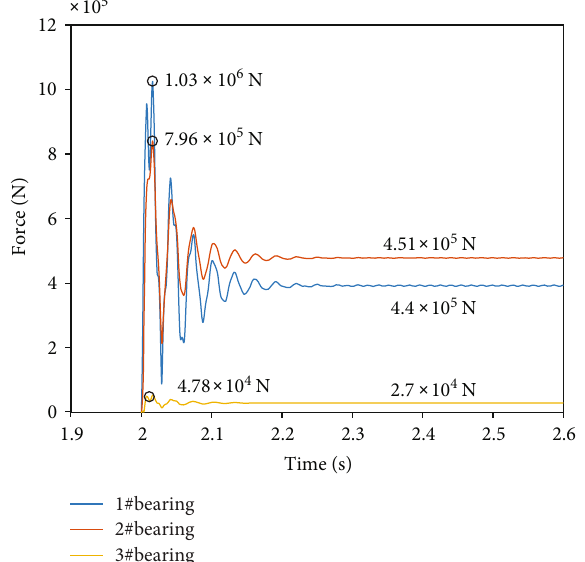
Figure 5: Reaction force of the support bearing of a low-pressure rotor